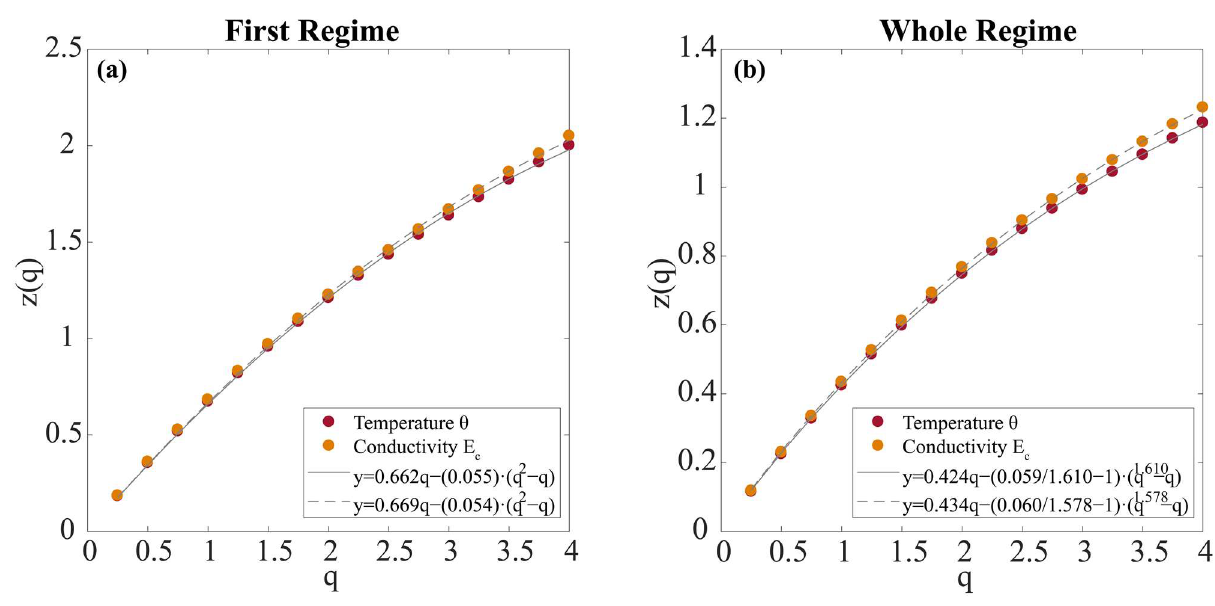
Figure 6. The structure function z ( q ) versus the order of the moment, q , for ( a ) the first regime (short times) and ( b ) the whole regime (long times) for temperature, θ, and conductivity, E c , time series and for the CTD30 data.